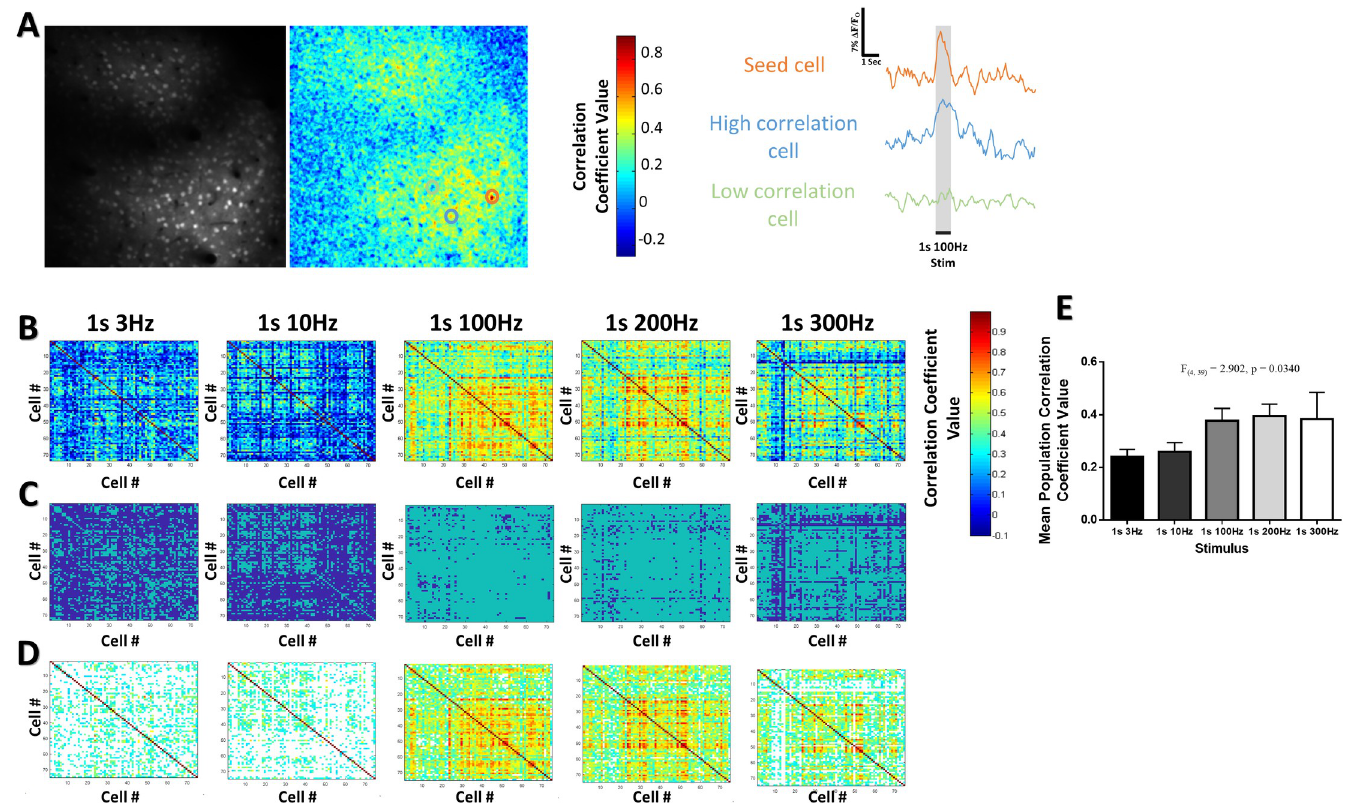
Fig 4. Stimulus-evoked pairwise correlations vary as a function of the stimulus frequency. ( A ) Example of a seed-cell based correlation technique for a 1s 100Hz stimulus at 130 μ m in the cHL of one animal. The Δ F/F o fluorescence over time for the seed cell (orange) was correlated against the fluorescence over time for all other pixels in the imaging frame to generate the correlation map displayed. Example fluorescence traces are shown to the right with an example of a cell with high (blue trace) and low (green trace) correlation to the seed cell. ( B ) Example heat map matrices of the stimulus-evoked correlation coefficient between a population of 74 neurons within the cFL somatosensory cortex of one example animal. ( C ) Bootstrapping was used to determine pairwise correlations greater than the 97.5 th percentile of the bootstrap and indicated by light blue (see methods). ( D ) The pairwise correlation values were re-plotted with the correlations that did not meet the bootstrap criteria excluded. ( E ) A significant effect of stimulus frequency on the mean population correlation coefficient value is observed across all animals (N = 10). � p < 0.05; �� p < 0.01; ��� p <